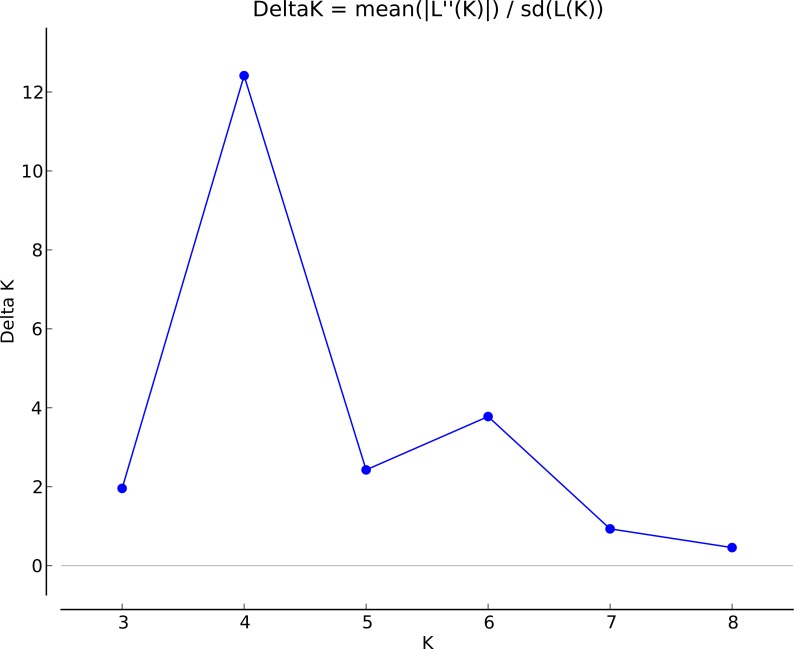
Delta K values from the method by Evanno, Regnatus & Goudet (2005).